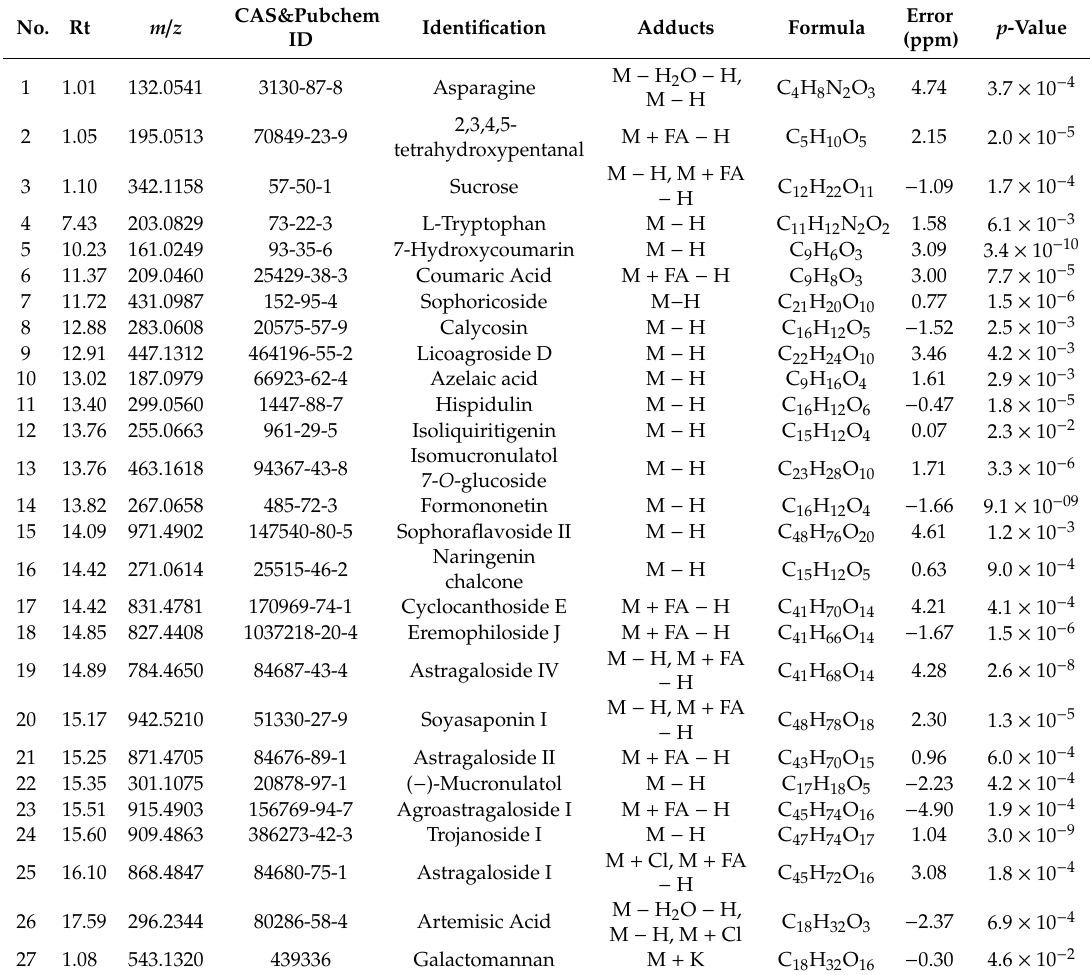
Table 1. The detailed information of identified components in positive ion mode and negative ion mode byUHPLC-ESI-Q-TOF-MS/MS.